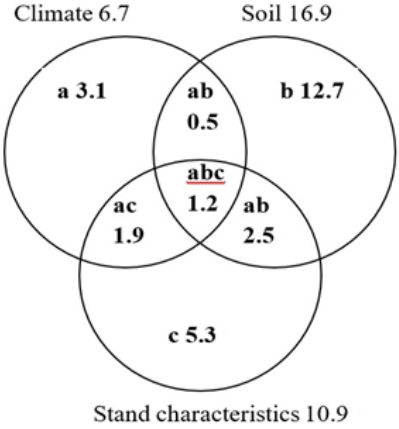
Figure 3. Variation partitioning of environmental factors and stand characteristics in accounting for the root biomass variation across forests in southwest China. The symbols a, b, c represent the independent effects of climate, soil, and stand characteristics, respectively; ab is the interactive effect of climate and soil; ac-, the interactive effect of climate and stand characteristics, bc-, the interactive effect of soil and stand characteristics, and abc-, the interactive effect of climate, soil and stand characteristics.